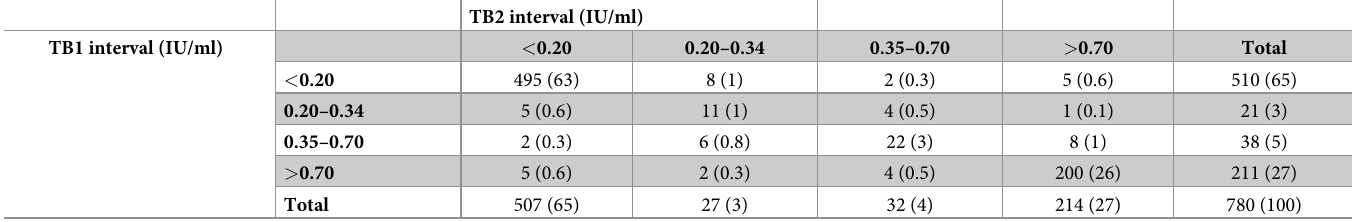
Table 3. Distribution of 780 HIV-negative women with respect to the conventional cut off 0.35 IU/ml and a borderline range (0.20–0.70 IU/ml) in TB1 and TB2. TB2 interval (IU/ml) TB1 interval